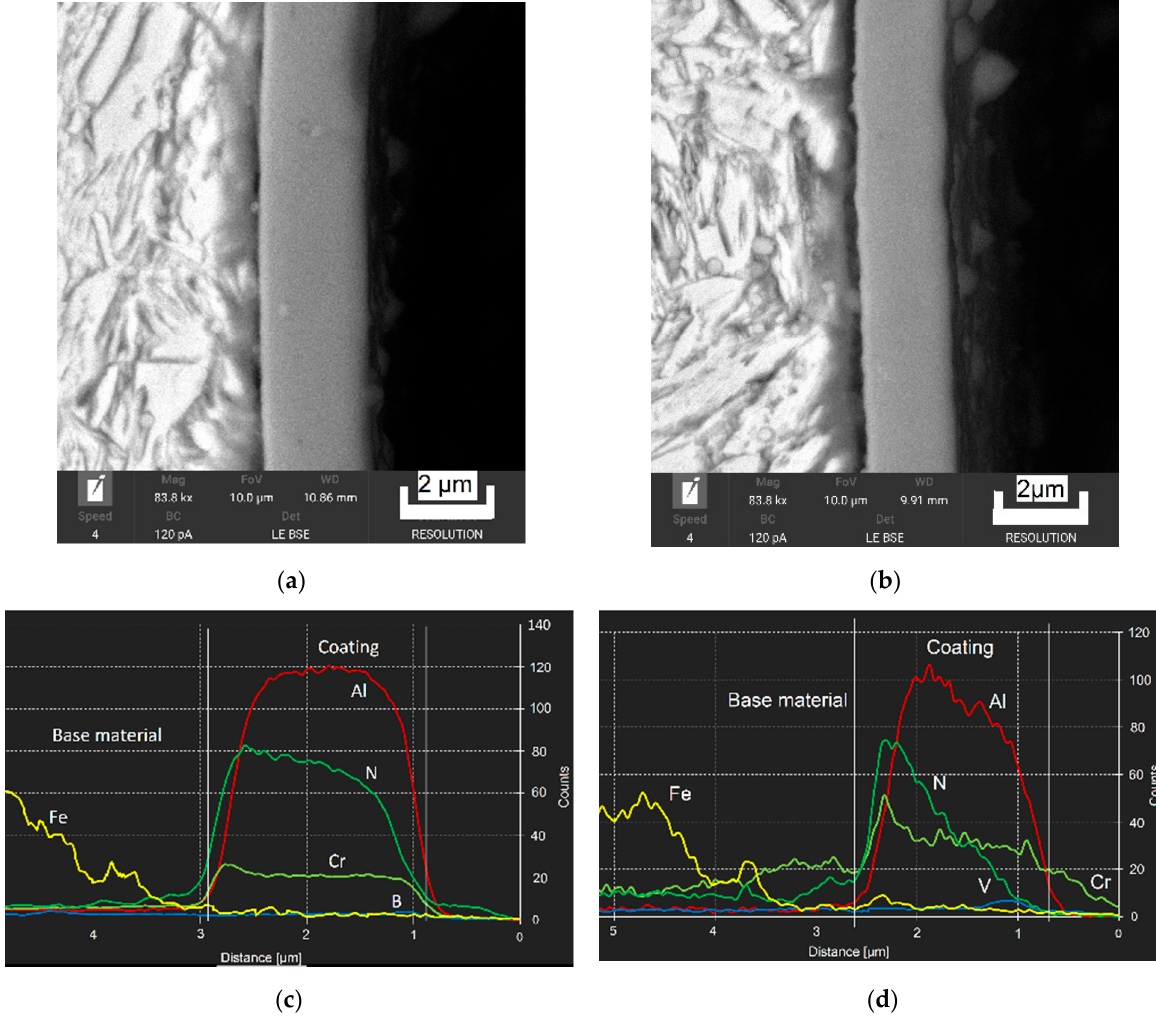
Figure 5. Features of the coatings on nitrided steel H13: ( a ) AlCrBN; ( b ) AlCrVN; ( c ) EDS line scan of AlCrBN coating; ( d ) EDS line of AlCrVN coating.